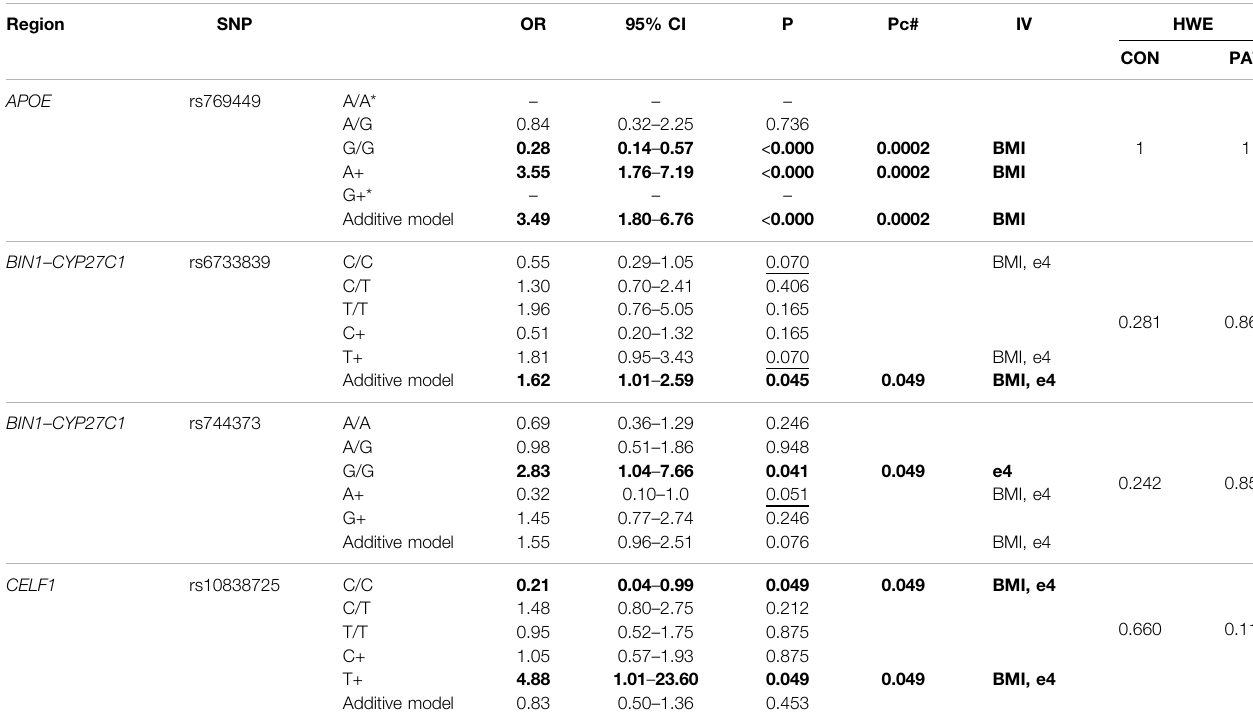
TABLE 4 | Signi fi cant results of the polymorphisms investigated with LOAD. Region SNP OR 95%